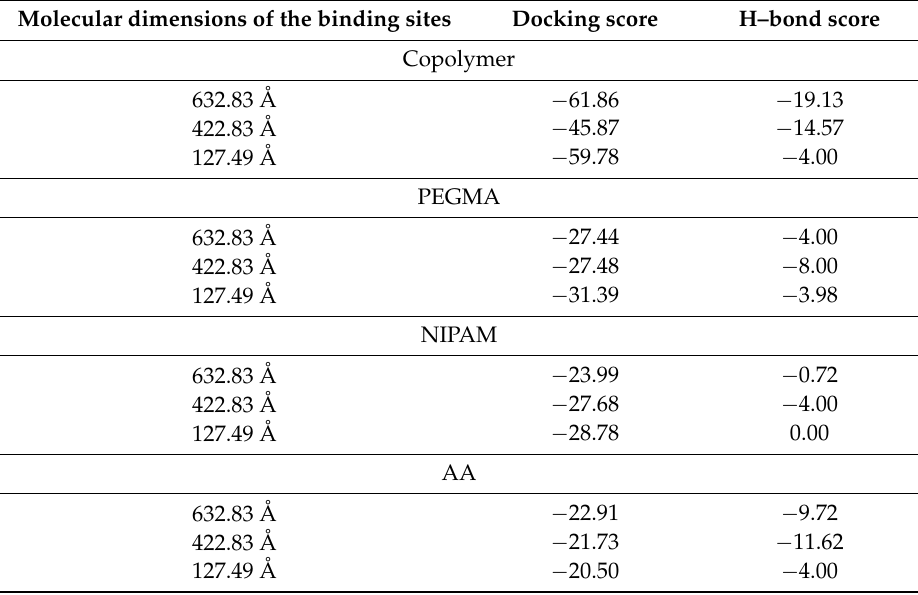
Table 1. Docking score and hydrogen bond (H-bond) score for the interaction of the copolymer, PEGMA, NIPAM and AA with the best selected docking position of